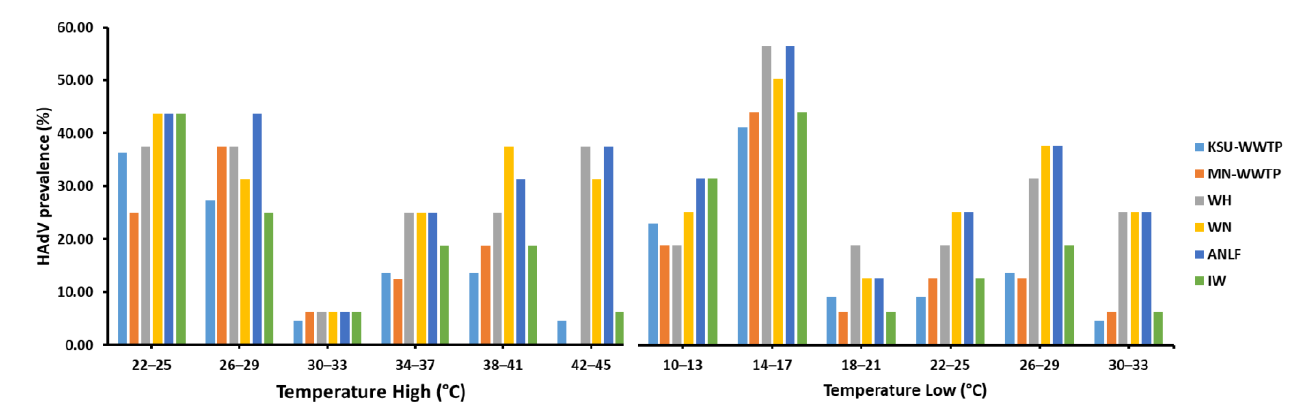
Figure 5. The influence of temperature variations on HAdV prevalence in different sampling locations.